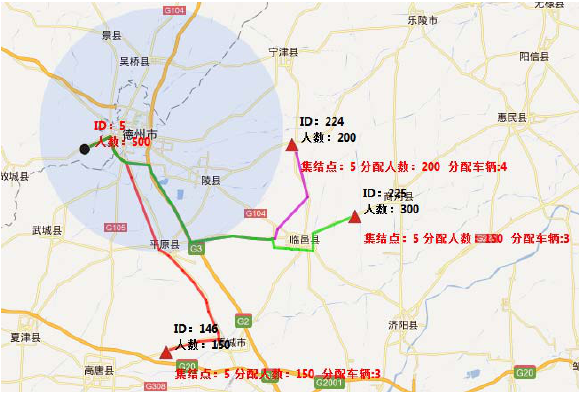
Figure 7. The route planning and vehicles assignment